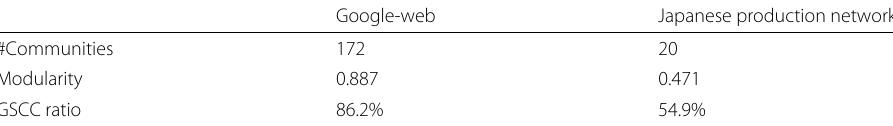
Table 4 Summary of the community detection using the Infomap algorythm for the Google-web network and the Japanese production network, showing the number of communities, the modularity of the GSCC corresponding to the Infomap partition, and the ratio of the number of the GSCC nodes in the subnetworks to that in the original